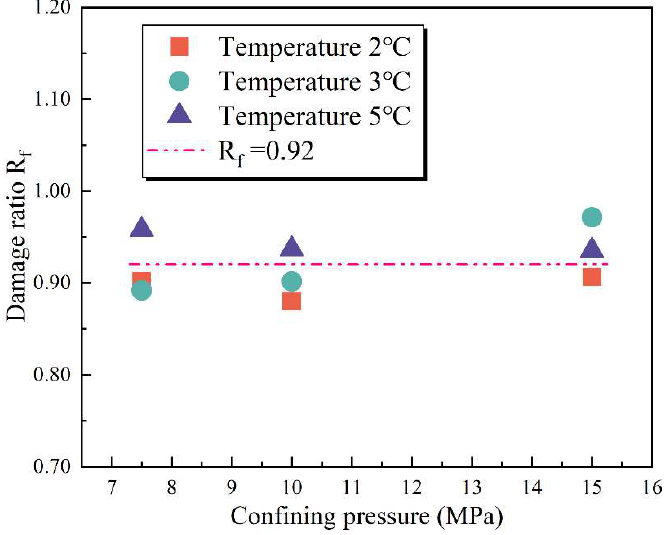
Figure 15. Calculated value of damage ratio 𝑅 (cid:3033) .